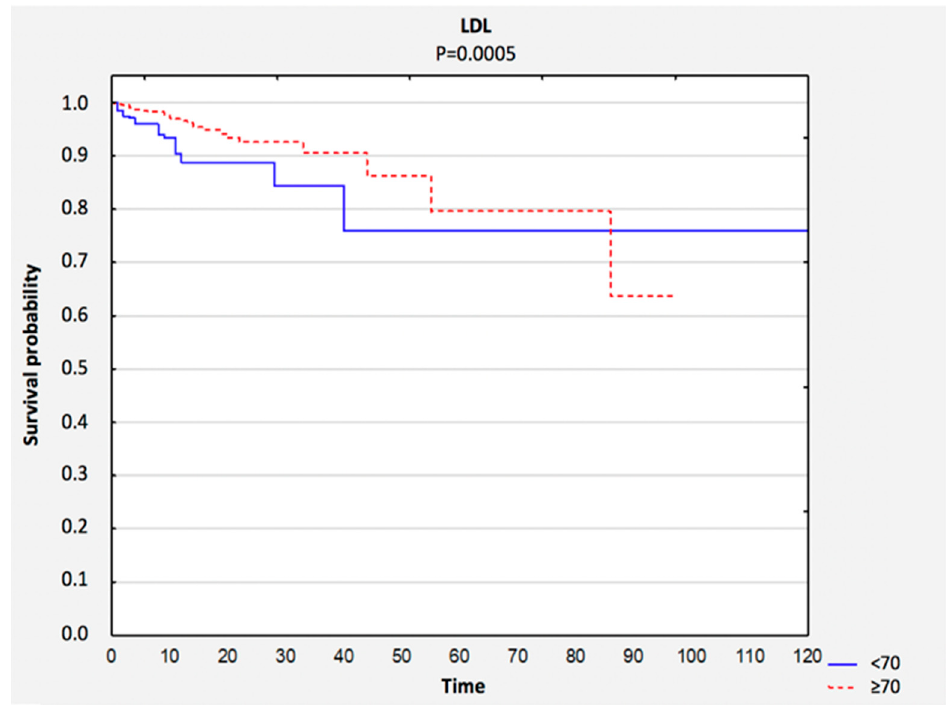
Survival curves were compared based on the LDL level. The total survival rate was 96% ( n = 1431). A significantly greater survival rate was observed among people with higher LDL levels (Figure 4). In the LDL < 70 group, the total survival rate was 91%, whereas in the LDL ≥ 70 group, it was 97% (Table 4).